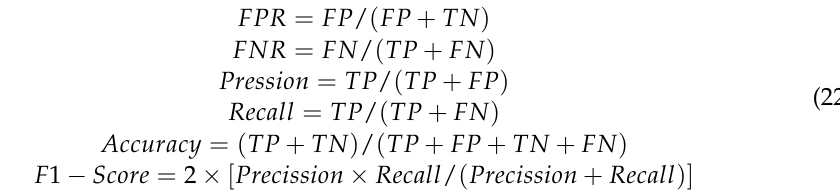
Table 2. Sand wave detection performance on Jiaozhou Bay 1.